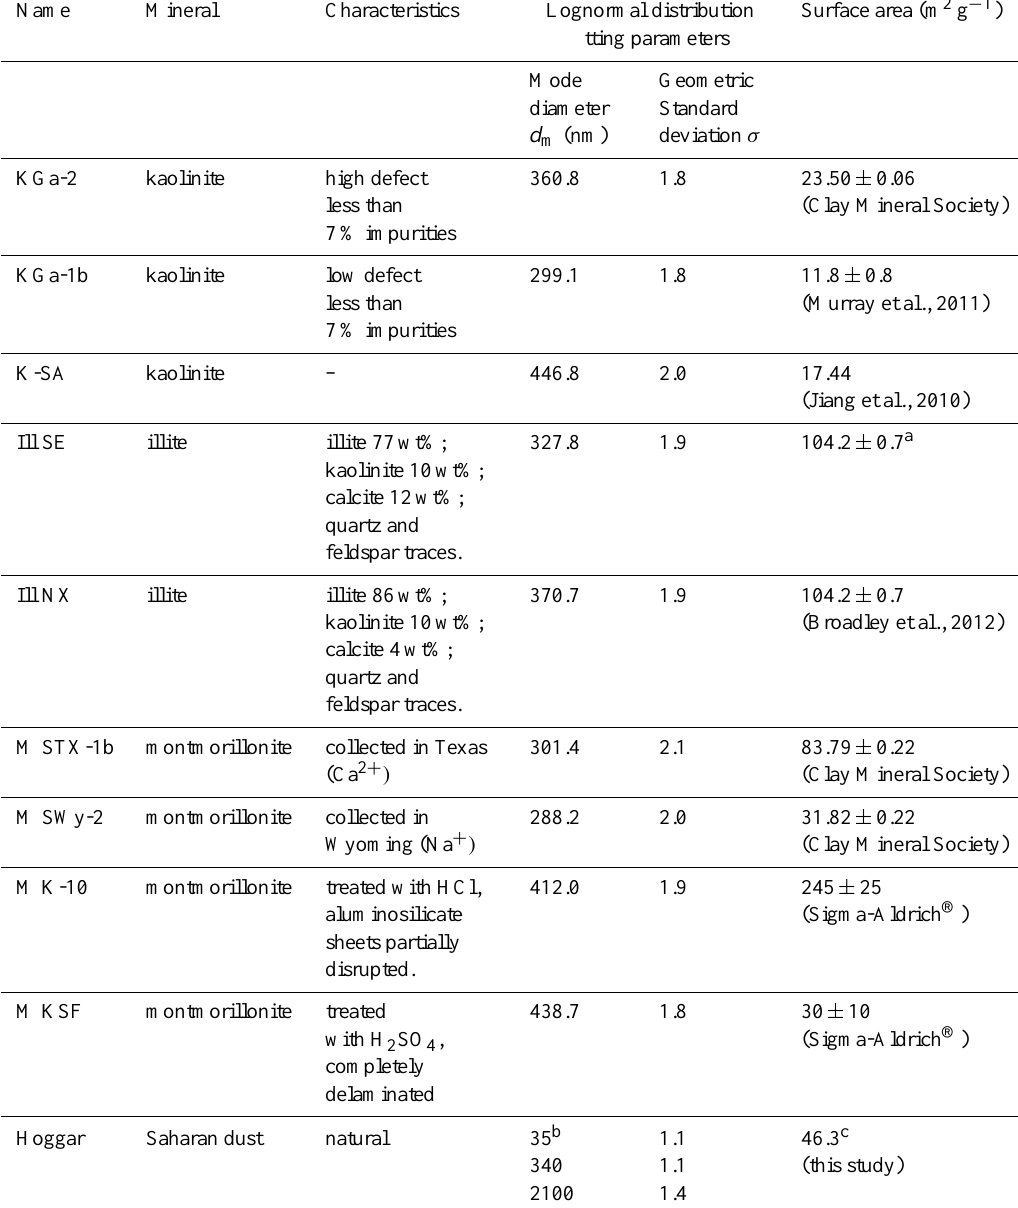
Table 1. Samples examined in this study. Exchangeable cations are given in brackets where relevant. Measured SMPS size distributions were fitted by lognormal size